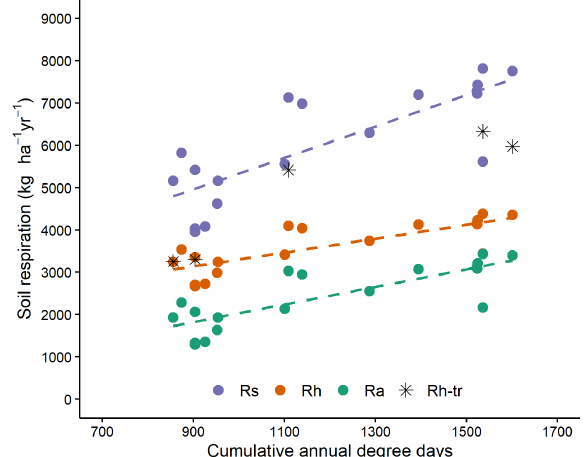
Figure 3. Seasonal soil respiration (183d: 1 May–31 October) with cumulative degree days for R s (total soil respiration), R h (het- erotrophic soil respiration) and R a (autotrophic soil respiration); stars indicates heterotrophic respiration assessed for trenched plots. R h and R a are otherwise calculated using the equation of Bond- Lamberty et al. (2004). All slopes are significant at the 0.001 level. More information in Table S2.